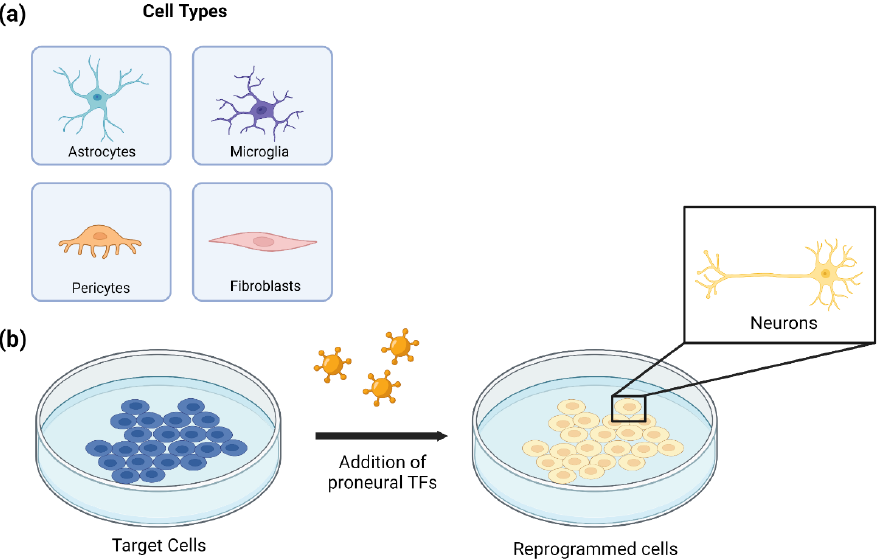
Figure 3. In vitro cell reprogramming. Several cell populations have been identified as targets capable of cell fate reprogramming when cultured with specific reprogramming factors. ( a ) Published litera- ture on in vitro cell reprogramming have targeted astrocytes, microglia, pericytes, and fibroblasts, among others, as candidate cell populations targeted for reprogramming. To achieve cell reprogram- ming, the targeted cells are cultured with particular transcription factors designed to change the cell fate into a cell of interest. ( b ) This process is commonly designed to generate induced neurons. As such, targeted cells are cultured with proneural transcription factors significant to neurodevelopment. cells are selectively reprogrammed into functional neurons and neuron-like cells. Table 1. Summary table of reprogramming methods. This table outlines the cell reprogramming methods highlighted throughout this review organized by target cell, transcription factor(s) used to mediate cell reprogramming, and the details surrounding the method of reprogramming. Summary Table of Reprogramming Models and Methods Cell Type